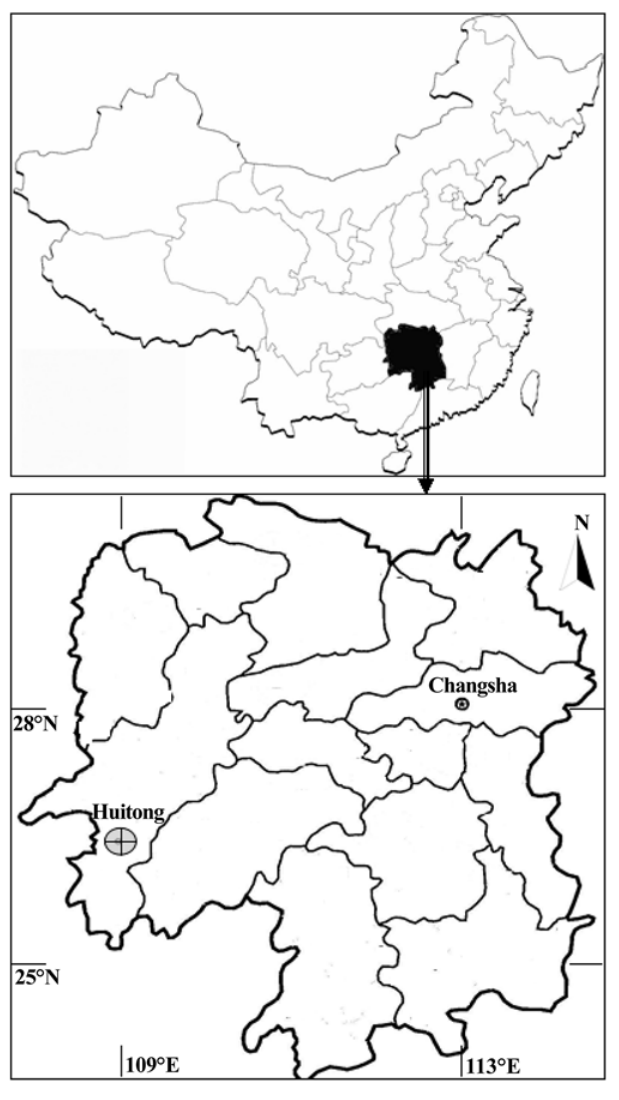
Fig 1. Geographical locations of the study